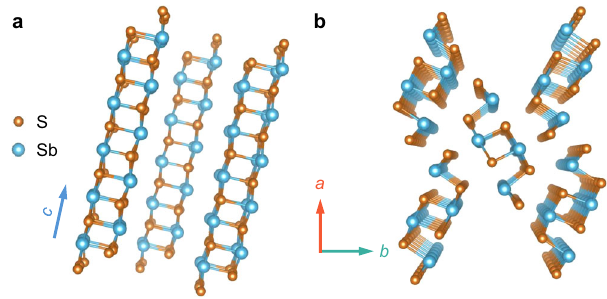
Fig. 1 Schematic diagram of quasi-1-dimensional structural Sb 2 S 3